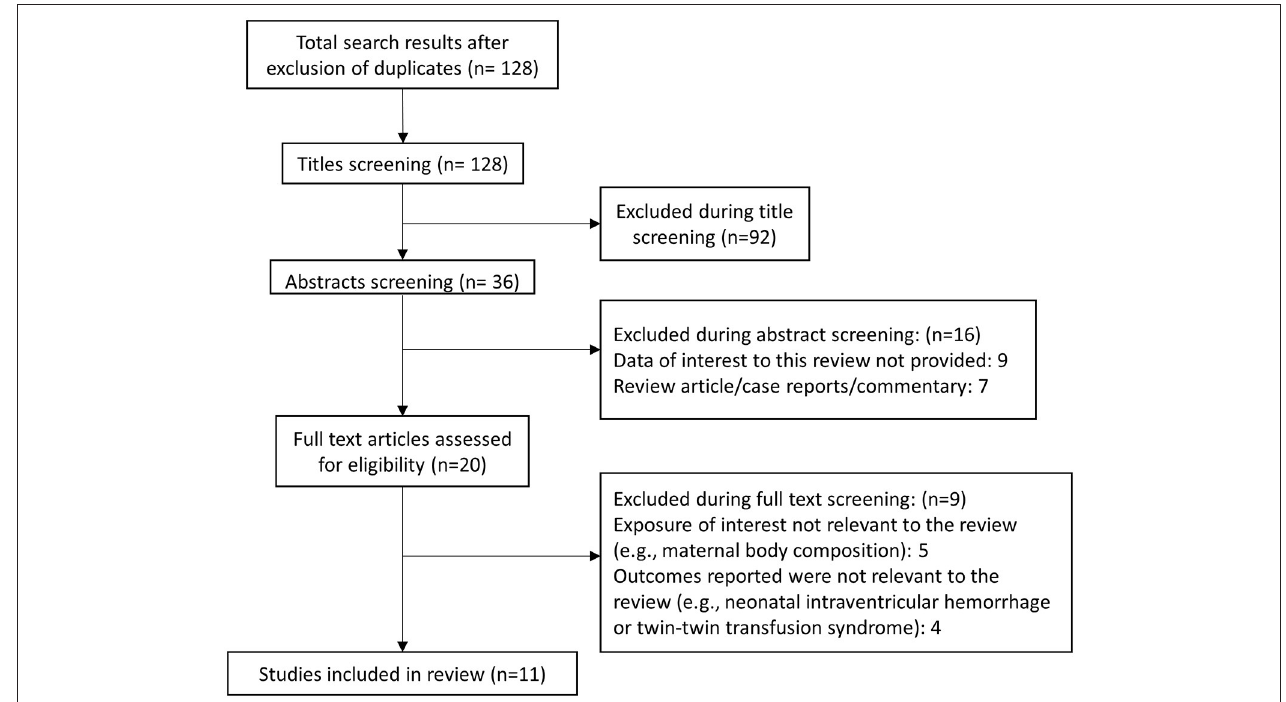
FIGURE 1 | Study inclusion selection